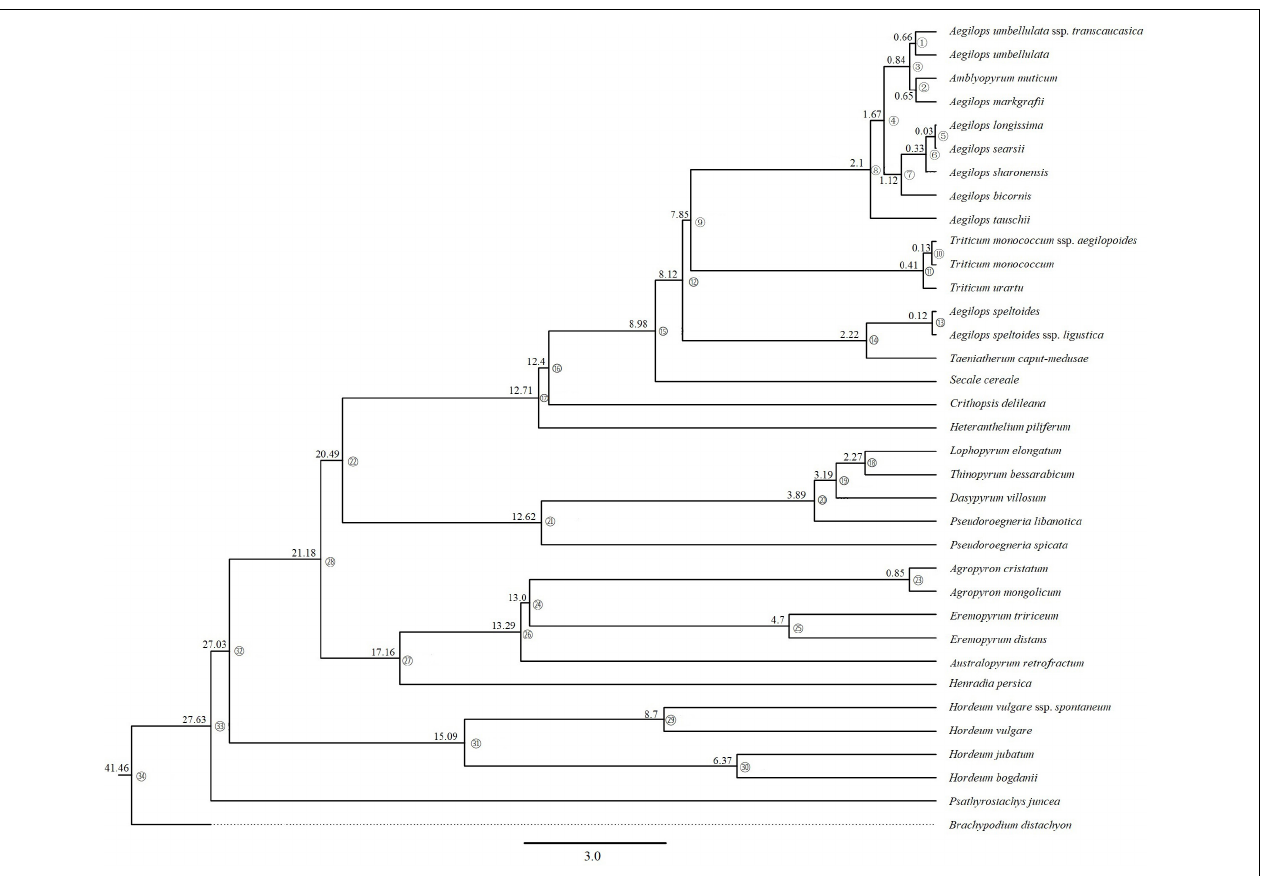
FIGURE 4 | Maternal time-calibrated phylogeny was estimated based on complete cp genomes of Triticeae with 95% confidence intervals BEAST